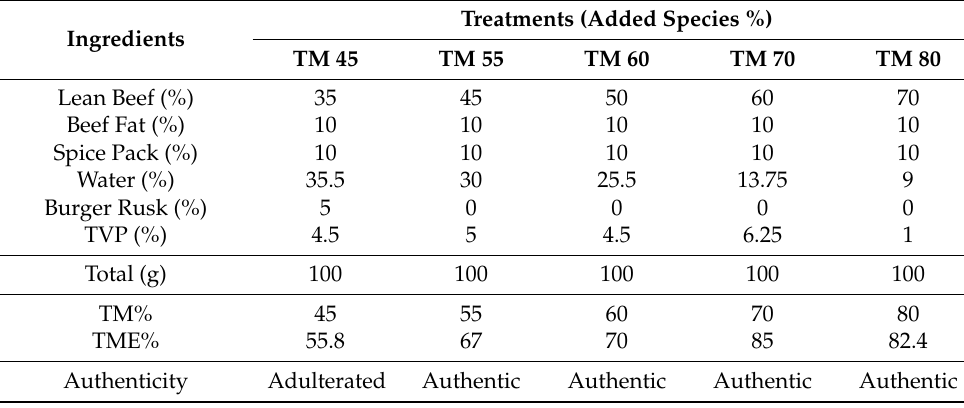
Table 3. Formulation of treatments for Patty 3 (value burger/value